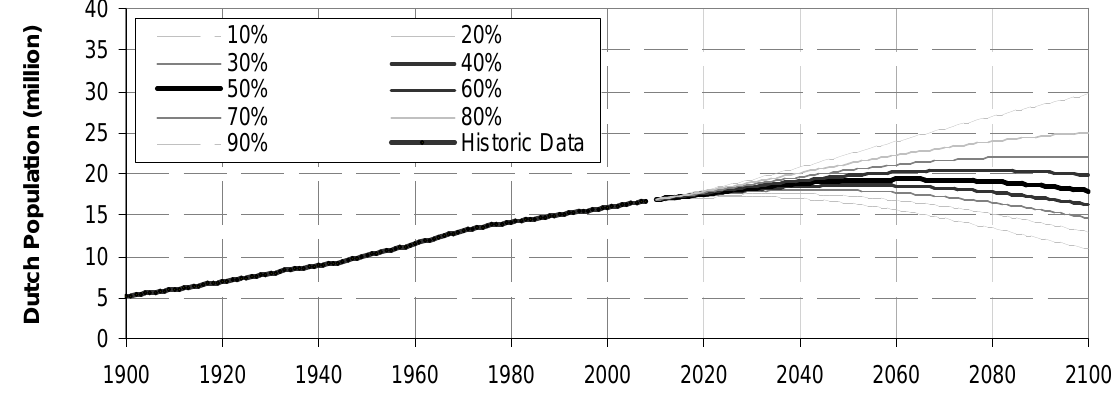
Figure 7. Probabilistic Forecast of the development of the Dutch